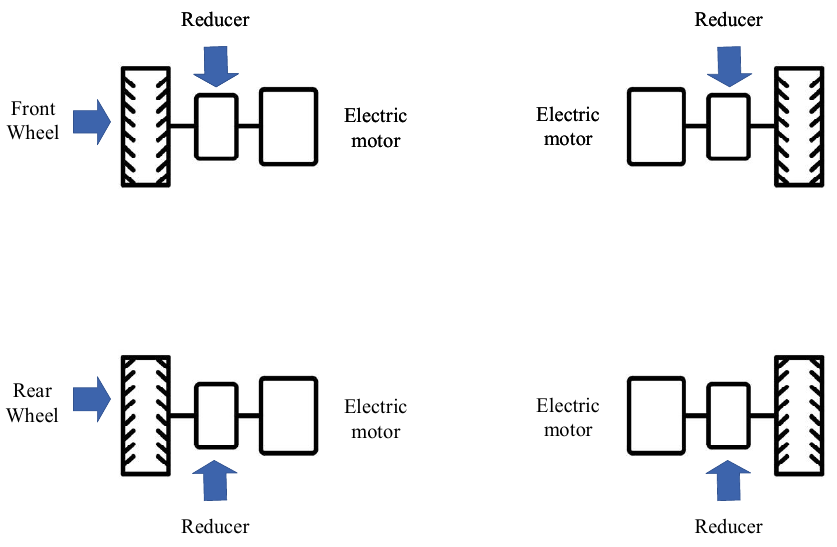
Figure 5. Power system layout structure of a four-wheel independent control electric vehicle.